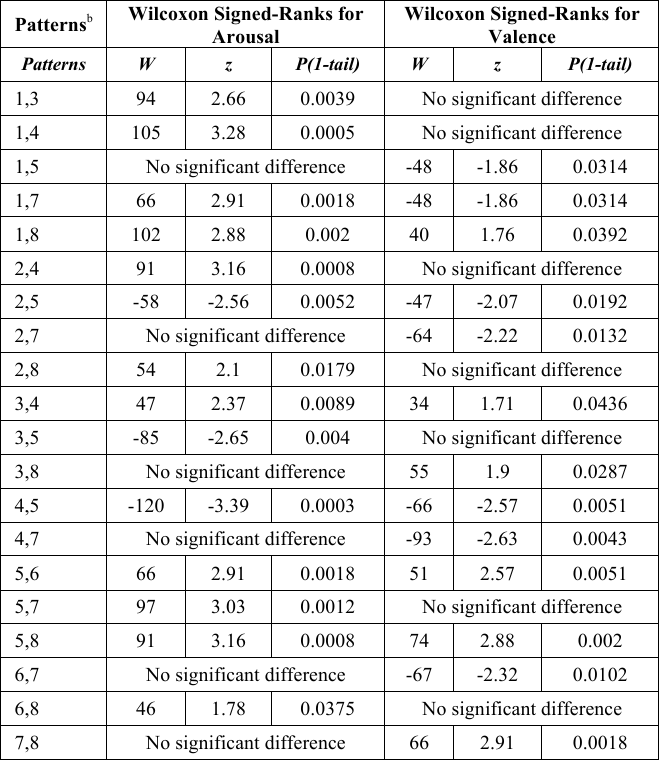
TABLE IV. O RDINAL D ATA T EST R ESULTS FOR A ROUSAL AND V ALENCE Patterns b